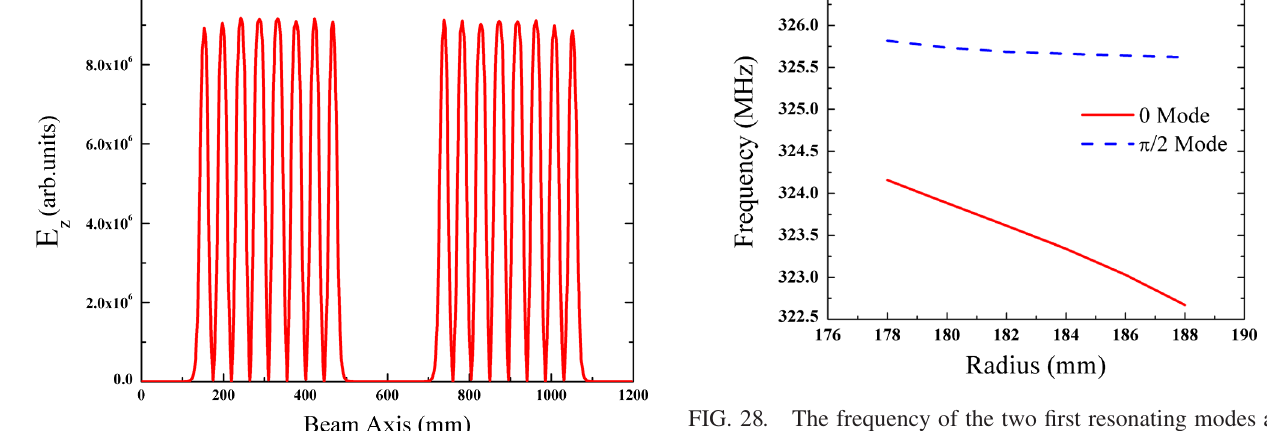
FIG. 28. The frequency of the two first resonating modes as a function of the radius of the coupling cell.